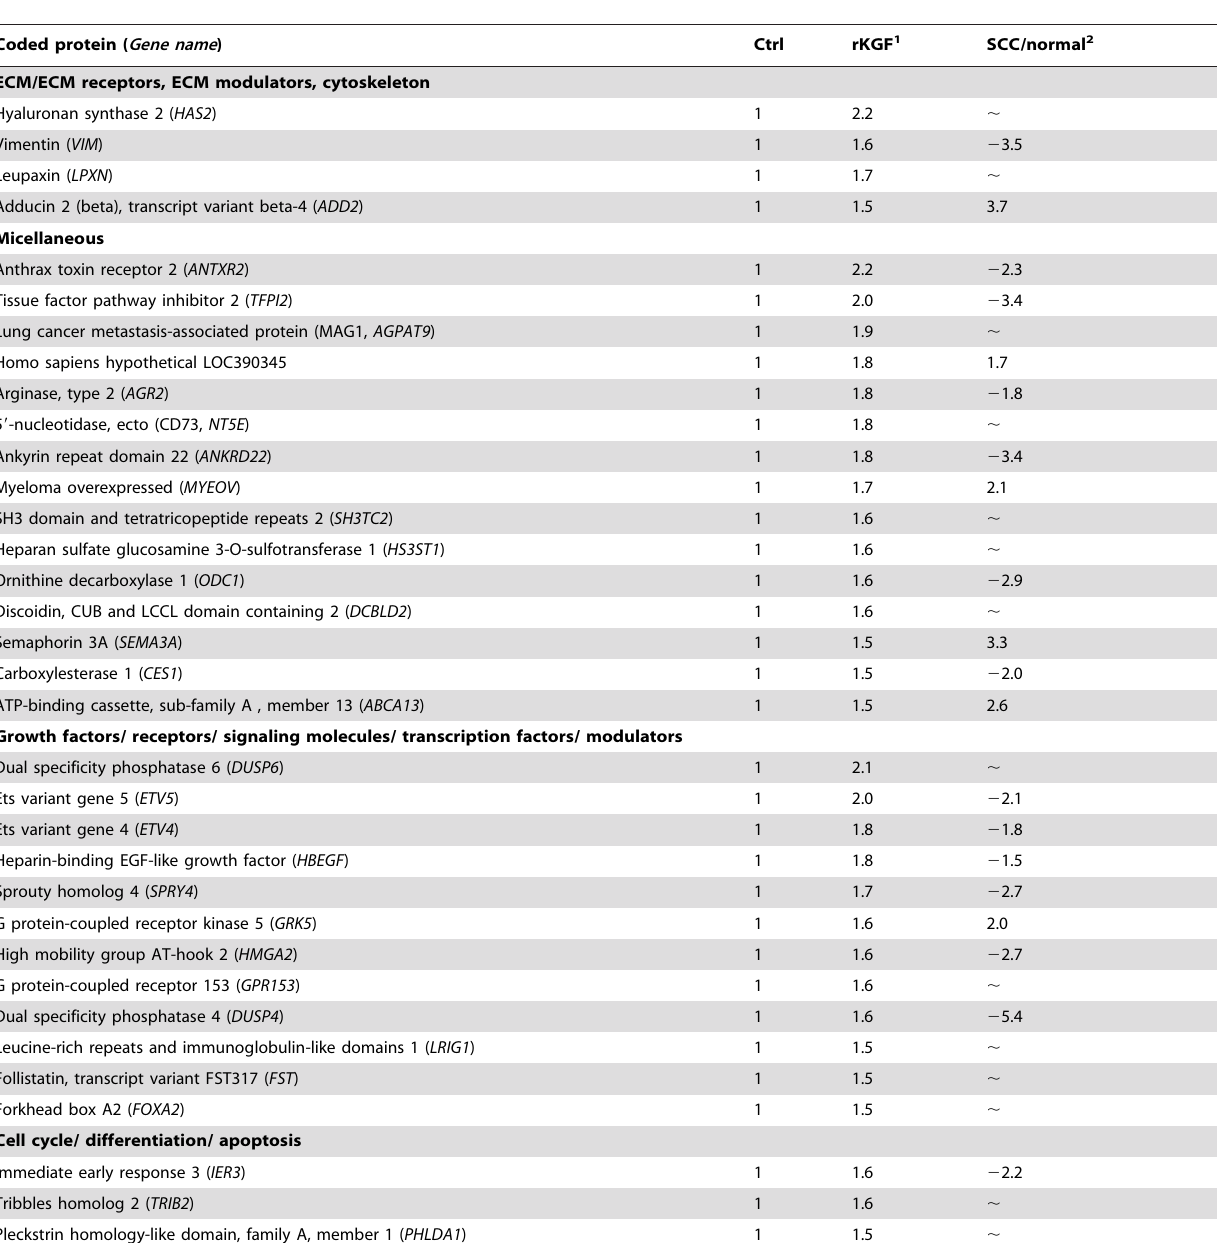
Table 1. Upregulation of different classes of genes in cutaneous SCC cells by KGF as determined by DNA microarray analysis.